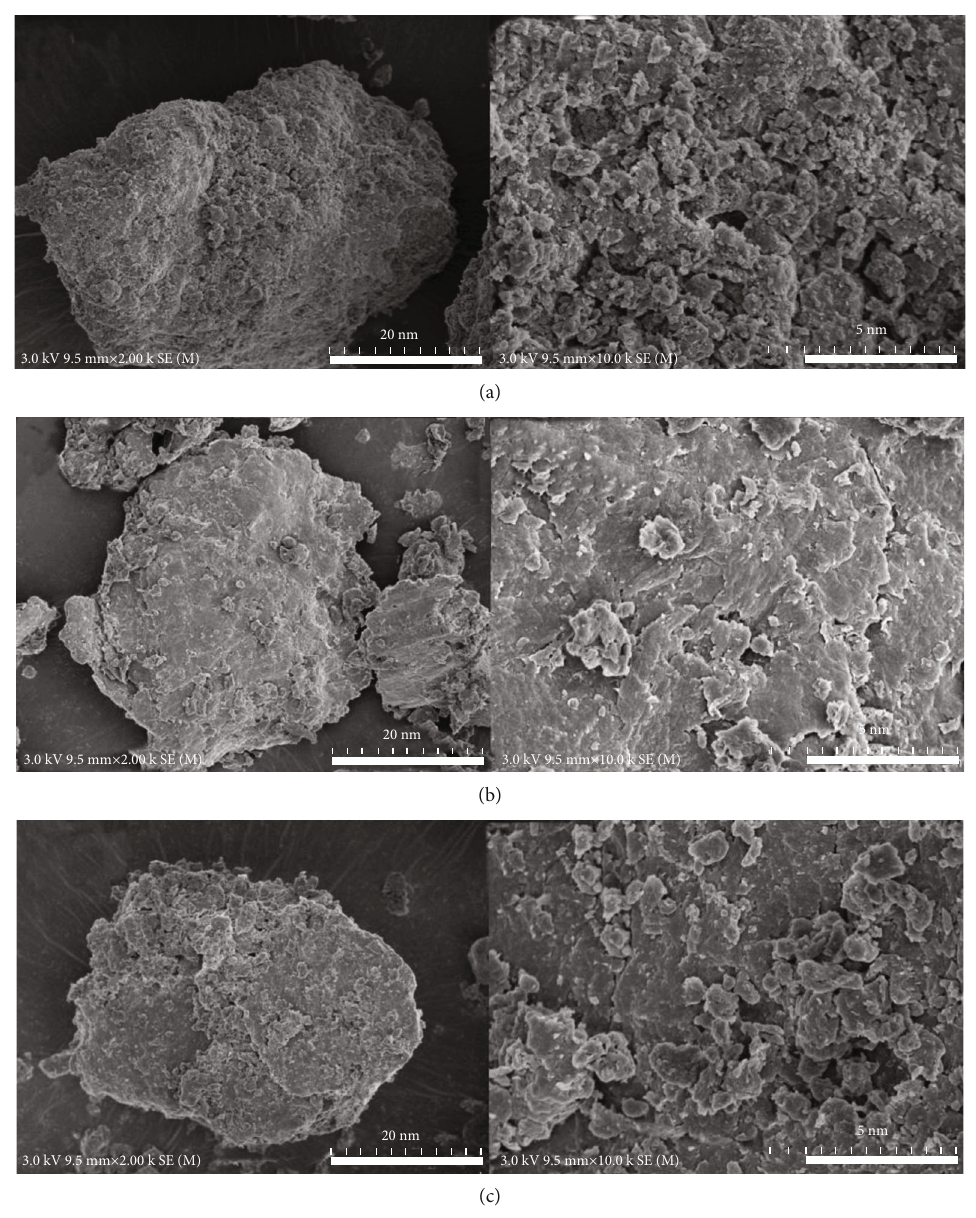
Figure 3: SEM images of AlBT (a), CSBT (b), and CSBT after Cr (VI) removal